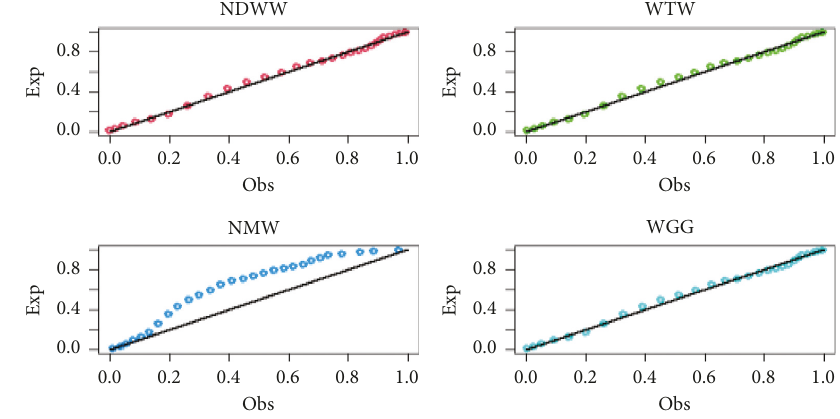
Figure 7: The pp plots for the dataset (3).